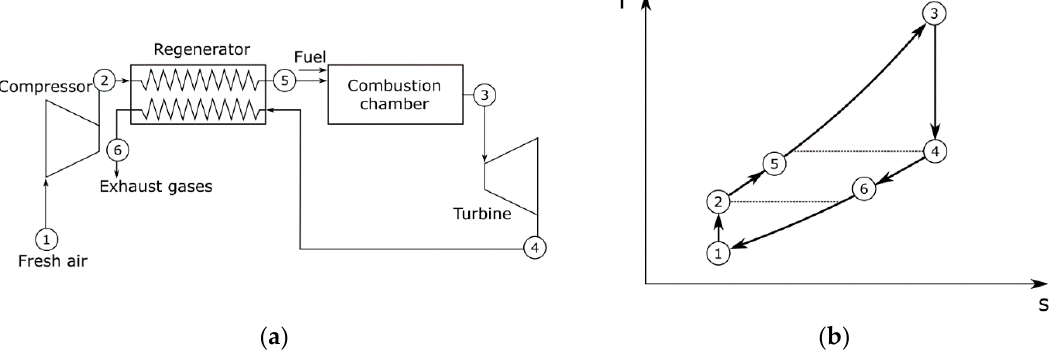
Figure 7. ( a ) Equipment and ( b ) T-s diagram of the ideal regenerative Brayton cycle.